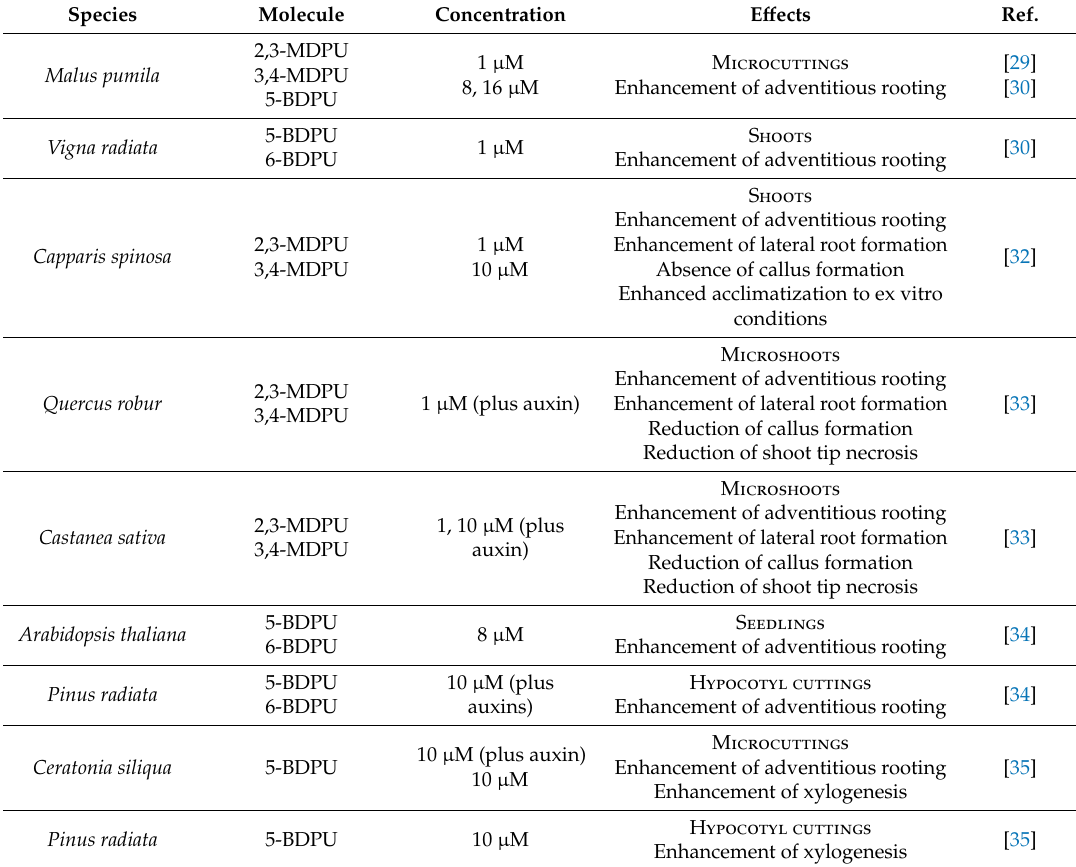
Figure 1. The molecular structure of urea derivatives. Table 1. Summary of the most evident morphological e ff ects of 2,3-MDPU, 3,4-MDPU, 5-BDPU or 6-BDPU